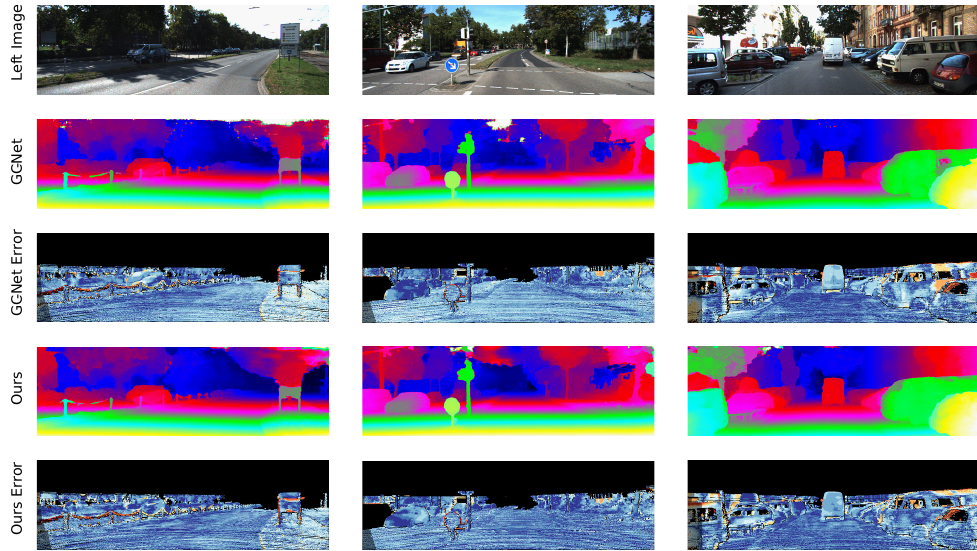
Figure 5. Results on KITTI 2015 stereo benchmark (include occluded pixels). Our network has better results in the foreground, which corresponds to cars and pedestrians.